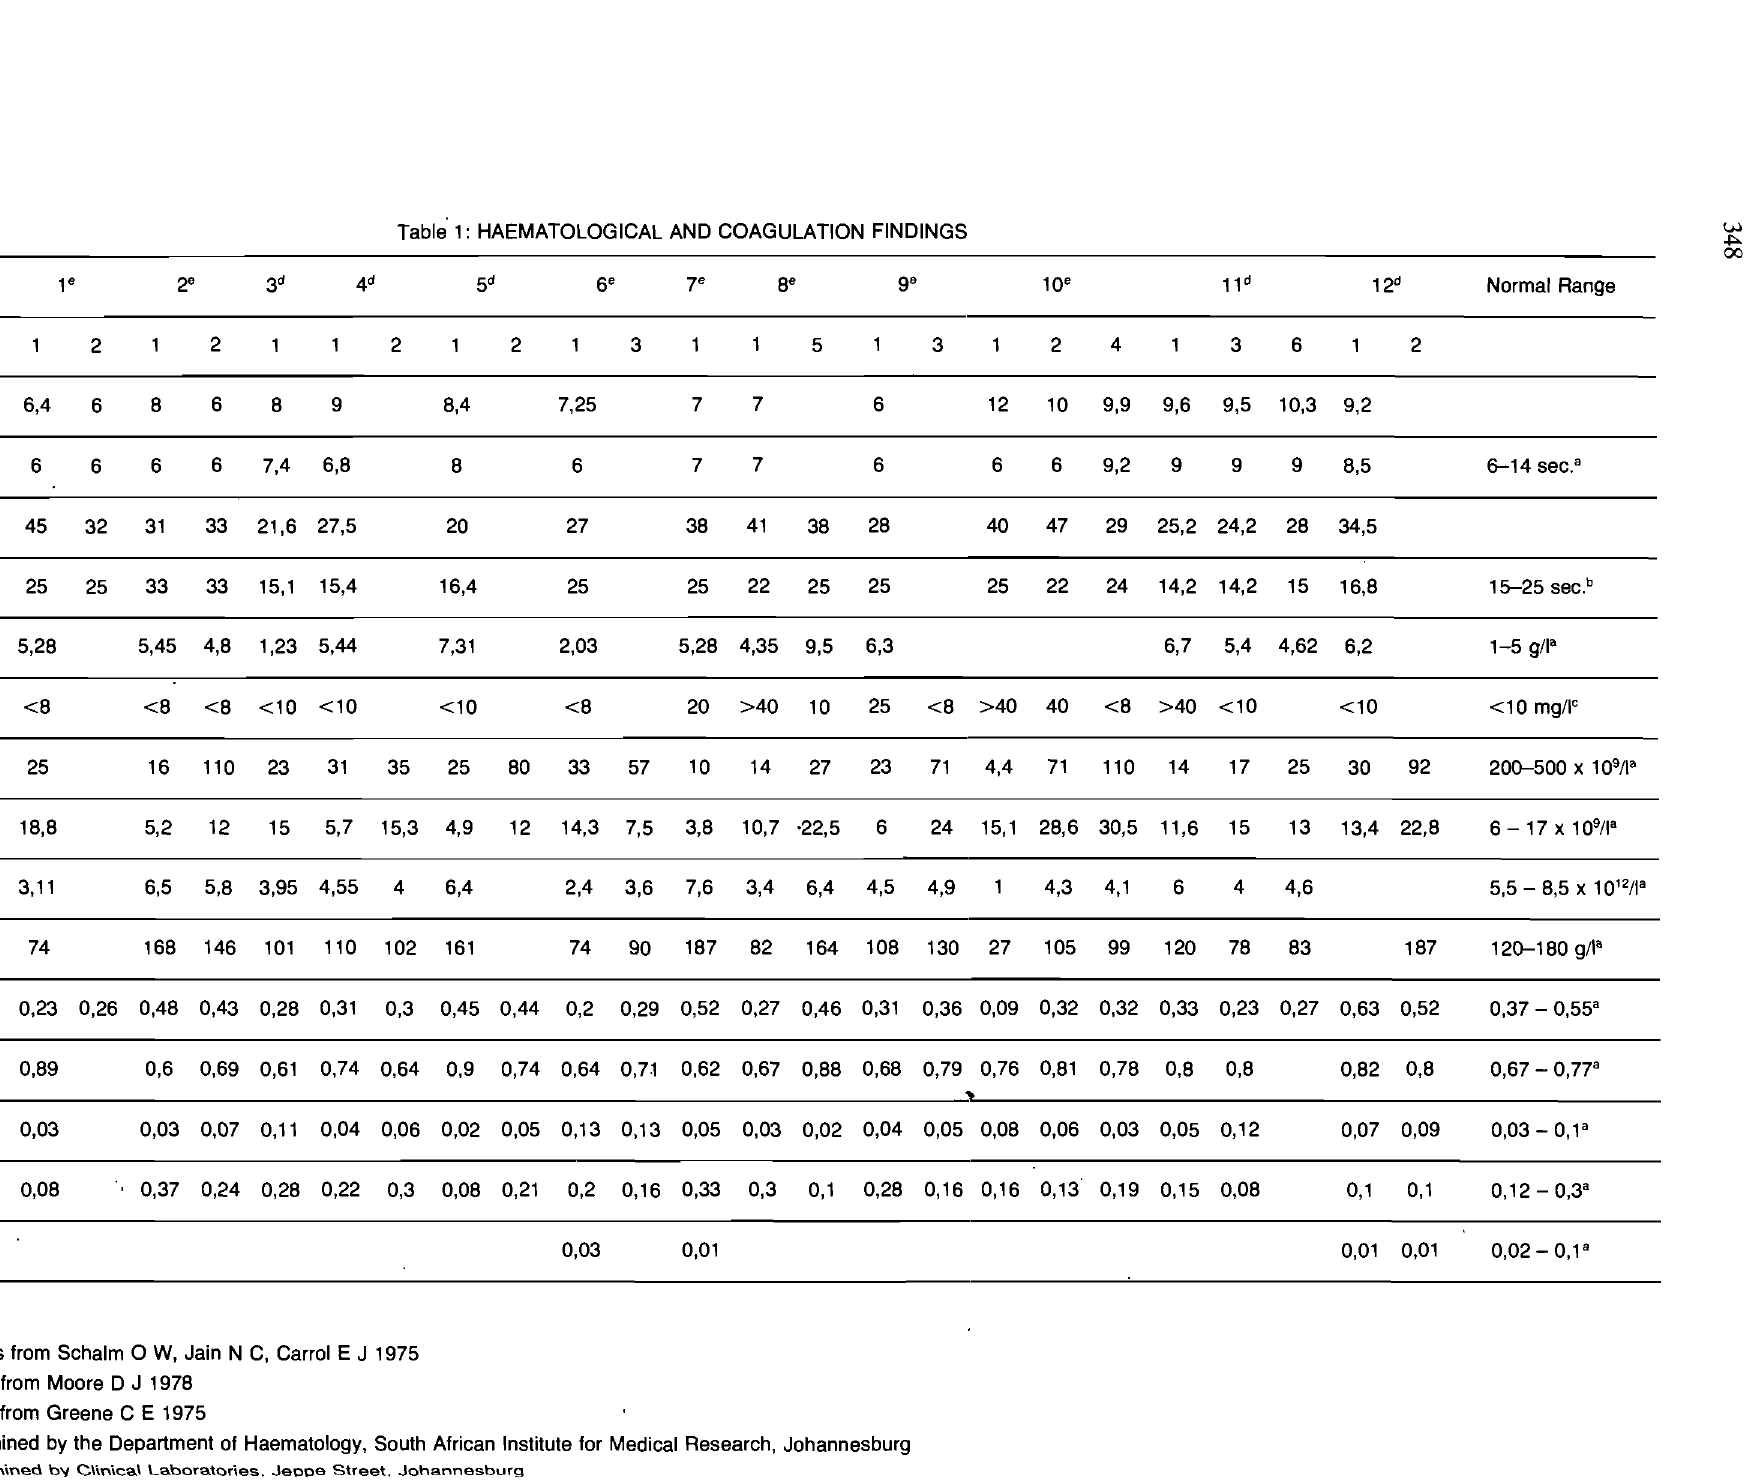
Table 1: HAEMATOLOGICAL AND COAGULATION